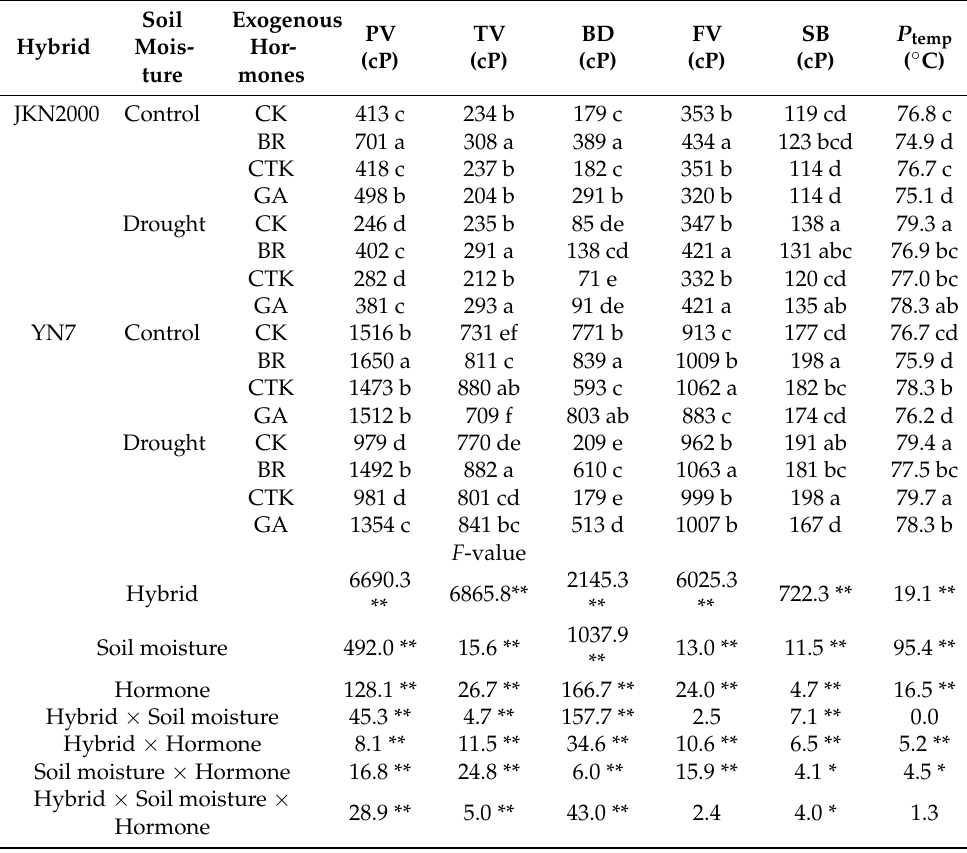
work, the low pasting viscosities may be caused by large granule size and high proportion of long chains in starch, as those viscosities were negatively correlated to SGS and λ max . In addition, BD was negatively correlated to protein content, indicating that proteins coated on starch granules restricted the starch granules broken during heating [50]. Table 1. The flour pasting properties with spraying exogenous phytohormones under post-silking control and drought